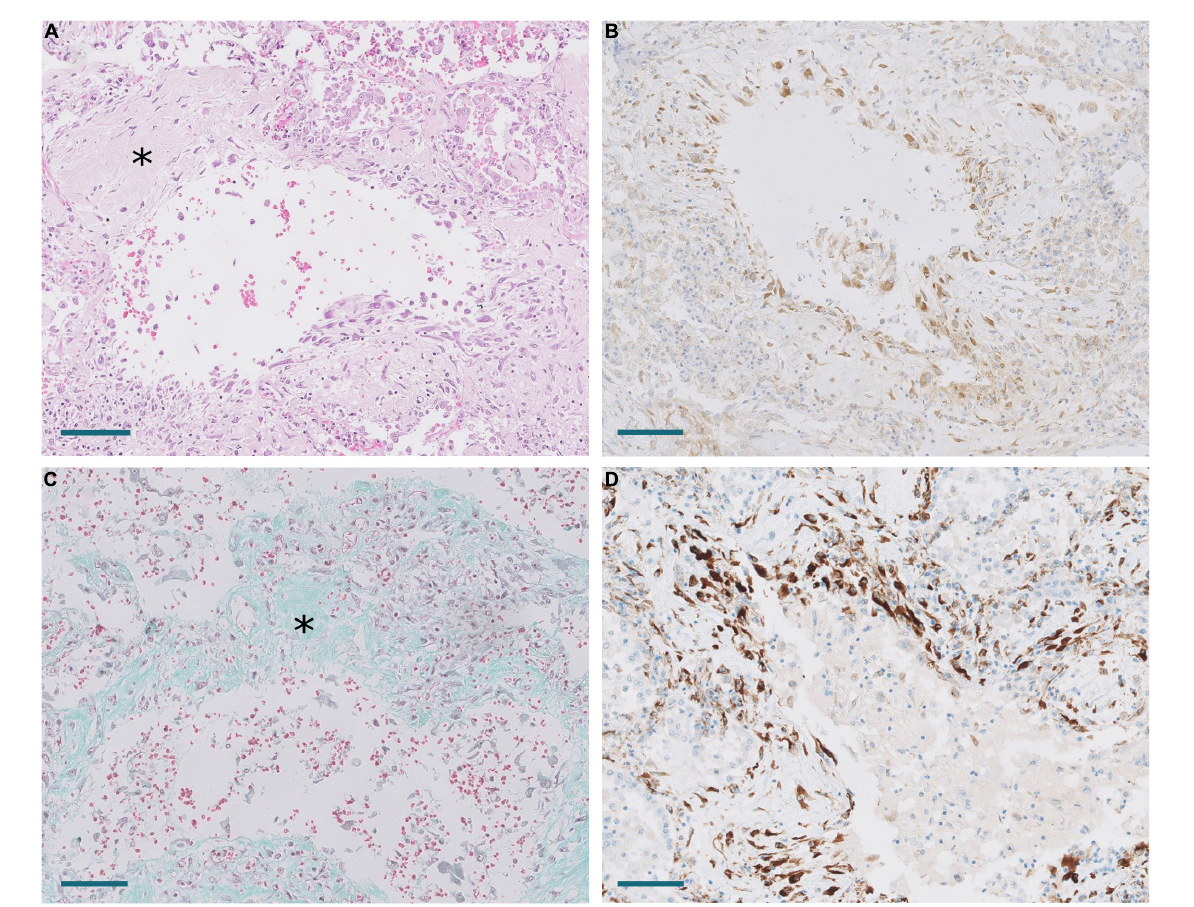
FIGURE8 Areas of periductal proliferation/fibrosis in Pt.18 with 43 days of disease evolution. (A) Hematoxylin and eosin. Note deposition of collagen ( ∗ ). Scale bar: 100 µ m. (B) Expression of CTHRC1. Scale bar: 100 µ m. (C) Masson trichrome stain. Note collagen deposition in green ( ∗ ). Scale bar: 100 µ m. (D) SPARC expression. Scale bar: 100 µ